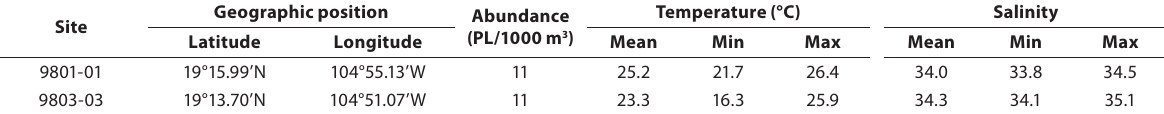
Table 1. Pickfordiateuthis vossi abundance and environmental conditions of sampled sites. Min = minimum, Max = maximum. Site